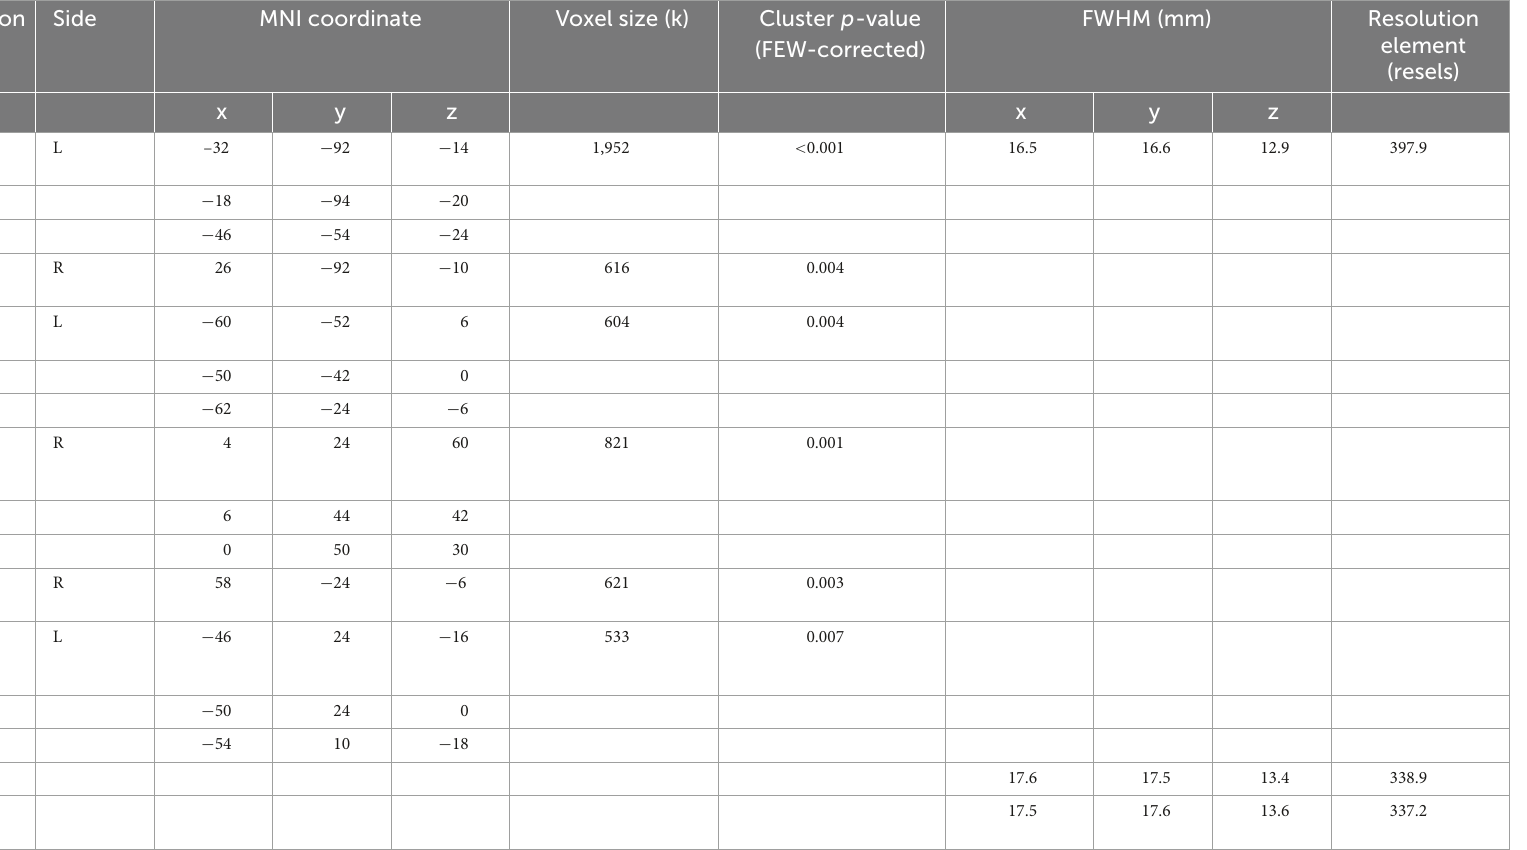
TABLE 1 Differences in brain activation by praise